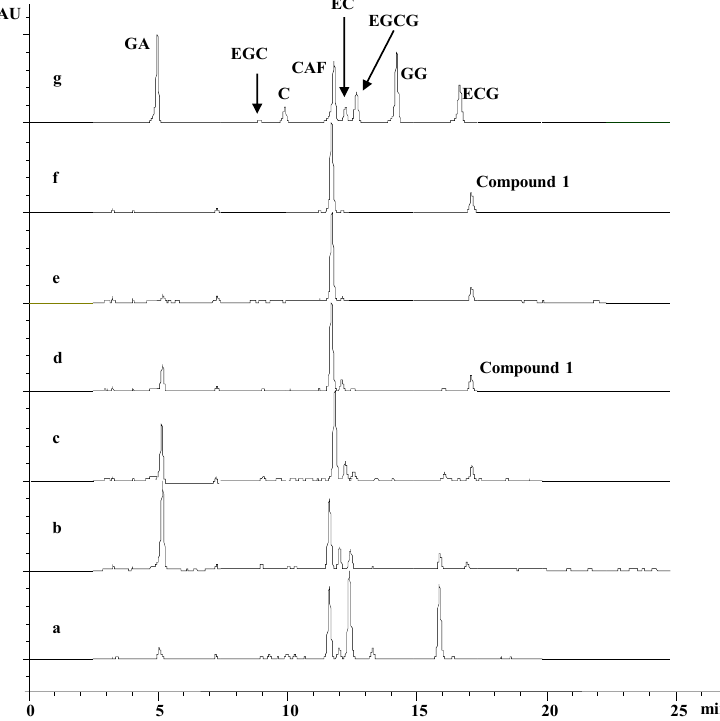
Figure 1. High-Performance Liquid Chromatography (HPLC) chromatogram of caffeine and catechins in raw material ( a ); fermented tea leaves collected on day 7 ( b ), day 14 ( c ), day 21 ( d ), day 28 ( e ), day 35 ( f ); and reference compound ( g ).